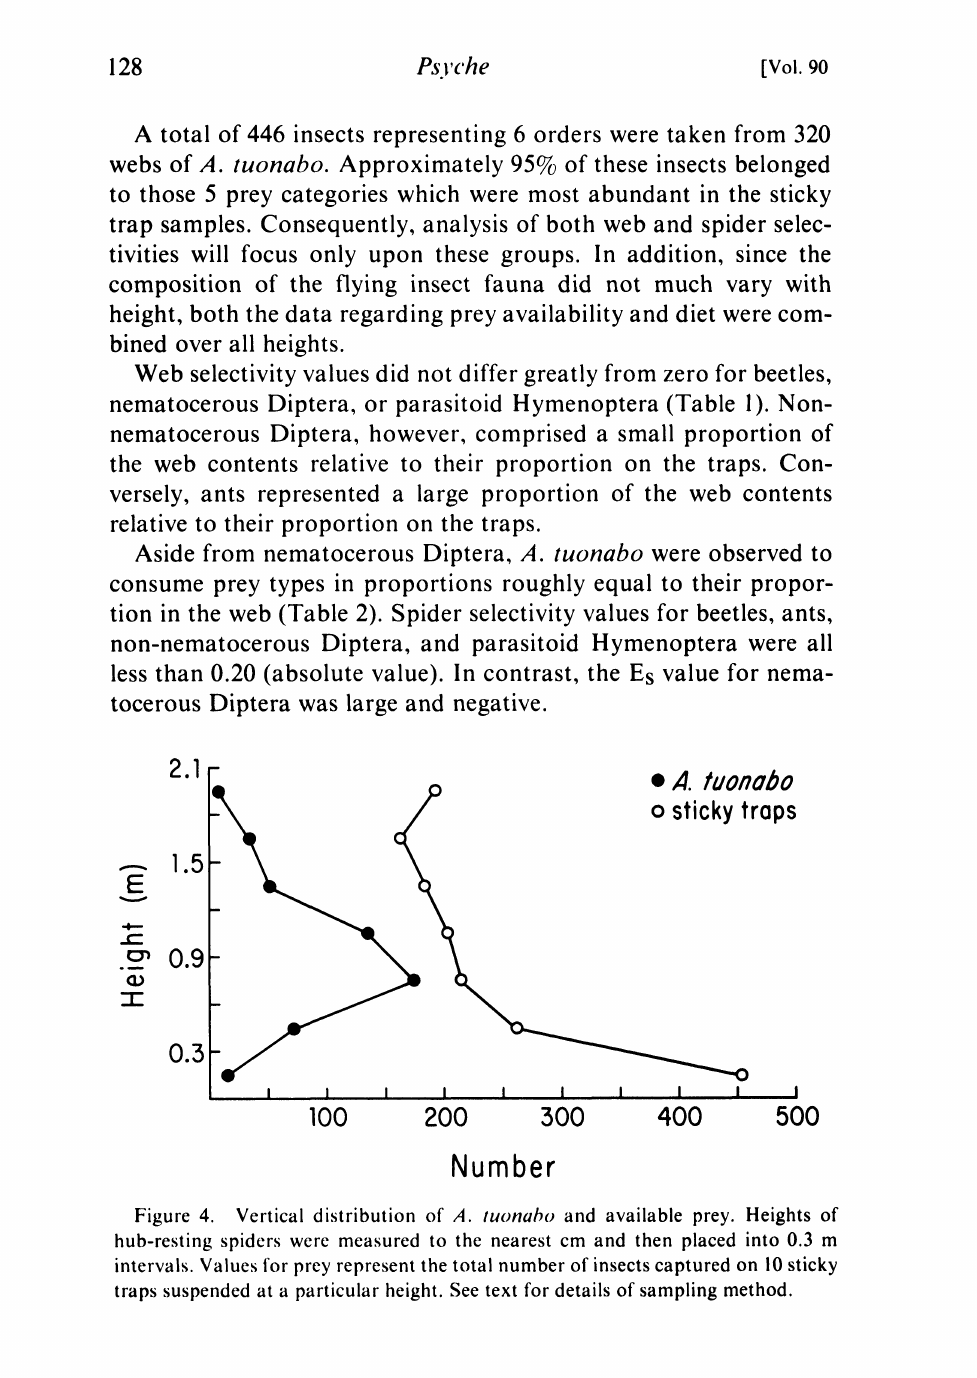
Figure 4. Vertical distribution of A. tuonaho and available prey. Heights of hub-resting spiders were measured to the nearest cm and then placed into 0.3 m intervals. Values for prey represent the total number of insects captured on l0 sticky traps suspended at a particular height. See text for details of sampling